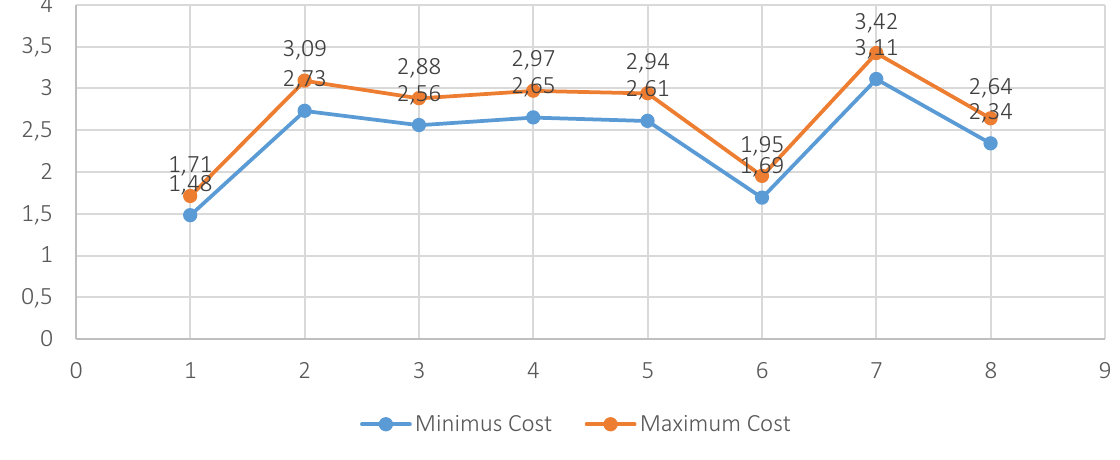
Figure 1. Estimated total cost of business set-up in GCC